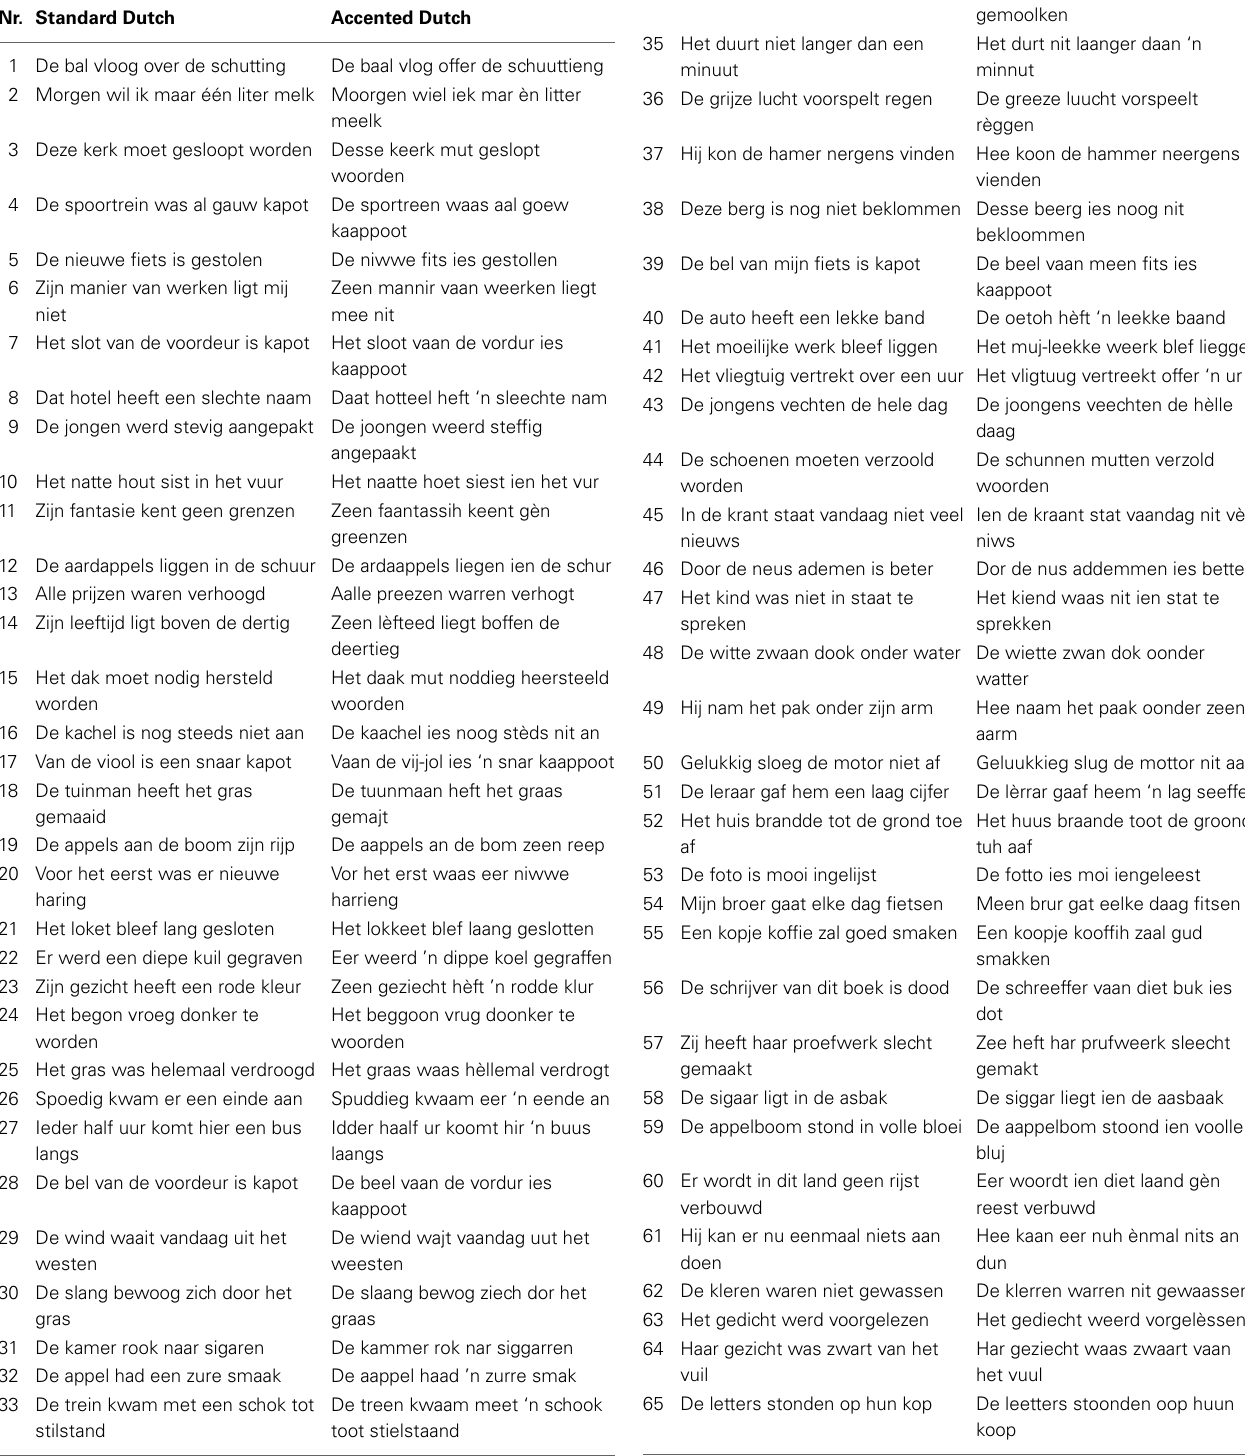
Table A1 | Test sentences from the Speech Reception Threshold corpus (Plomp and Mimpen,